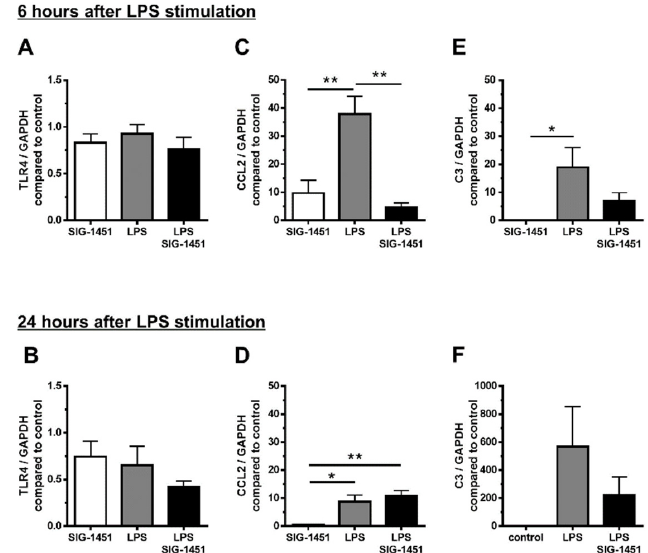
Figure 5. RT-qPCR analysis of inflammatory-response-related genes in cultured rMC-1 cells. Gene expression in rMC-1 cells was investigated for 6 h ( A – C ) and 24 h ( D – F ) after LPS stimulation. Independent experiments were performed. Data are represented in terms of the mean ± SE values ( n = 6, Tukey’s multiple comparisons test; *, ** p < 0.05, 0.01).